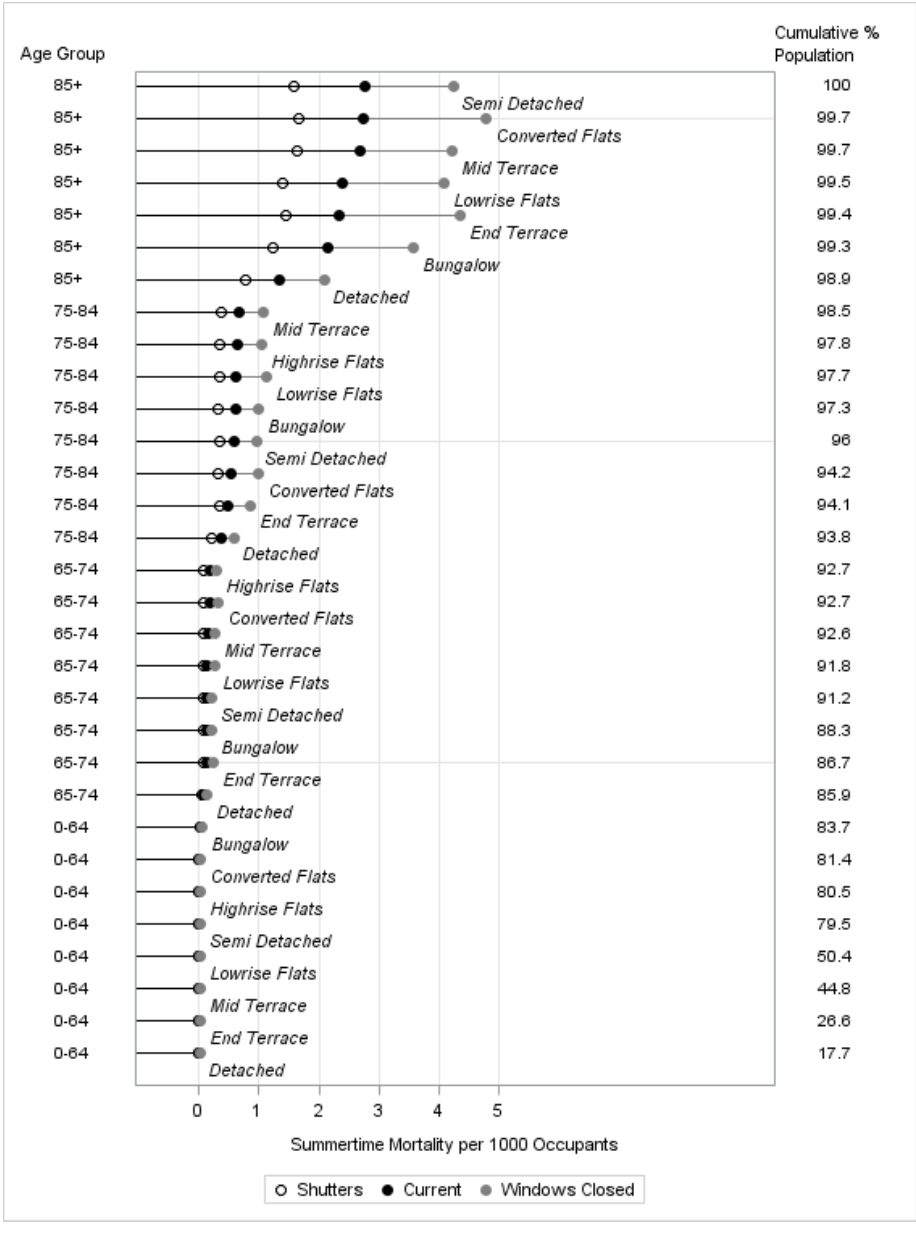
Figure 5. The median mortality per 1000 occupants over the 2030 summer by occupant age classification and dwelling type for the current stock, and with shutters or windows closed. The cumulative frequency of each age class/dwelling variant is shown on the secondary axis.